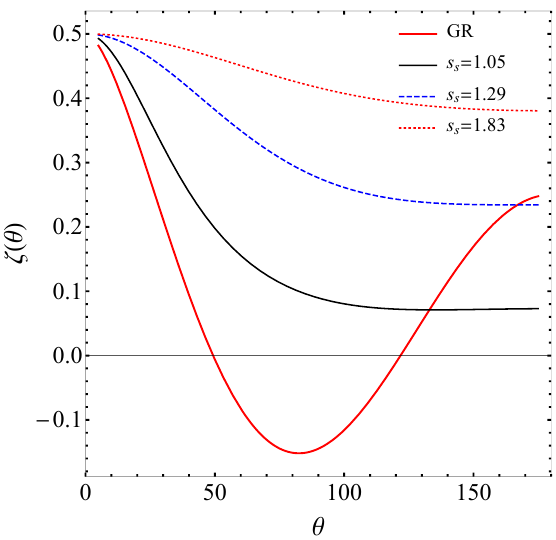
Figure 2. The normalized cross-correlation function ζ ( θ ) = C s ( θ ) / C s ( 0 ) for the scalar GW when the c i s take the values shown in Table